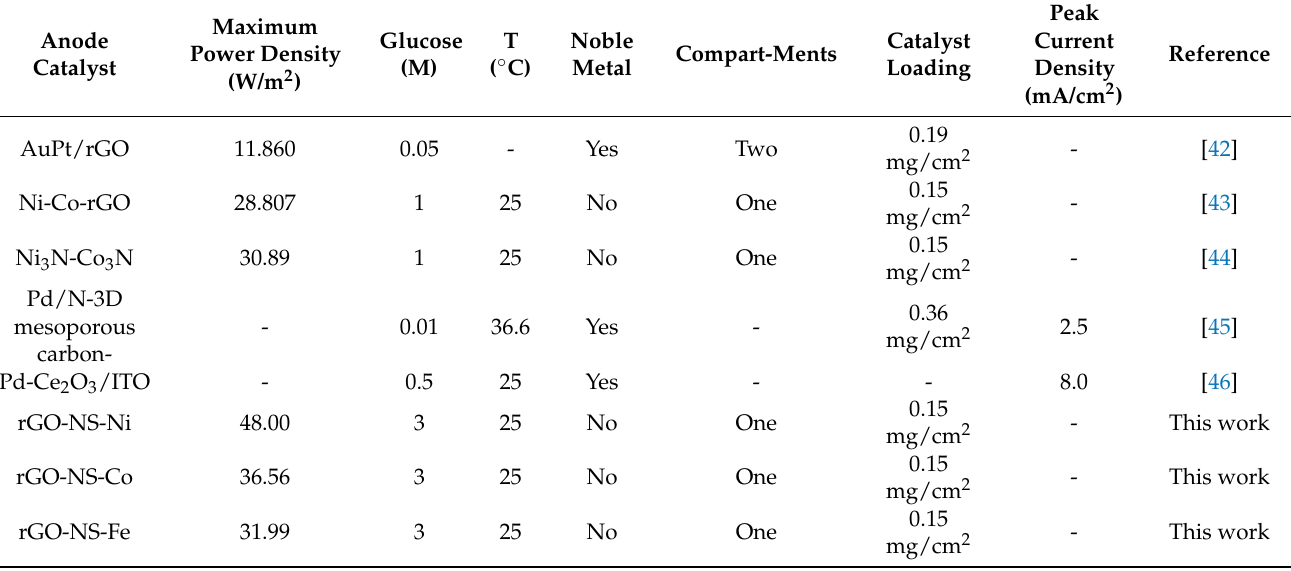
Table 2. Comparison of power generation performance of DGAFCs equipped with different anodes.